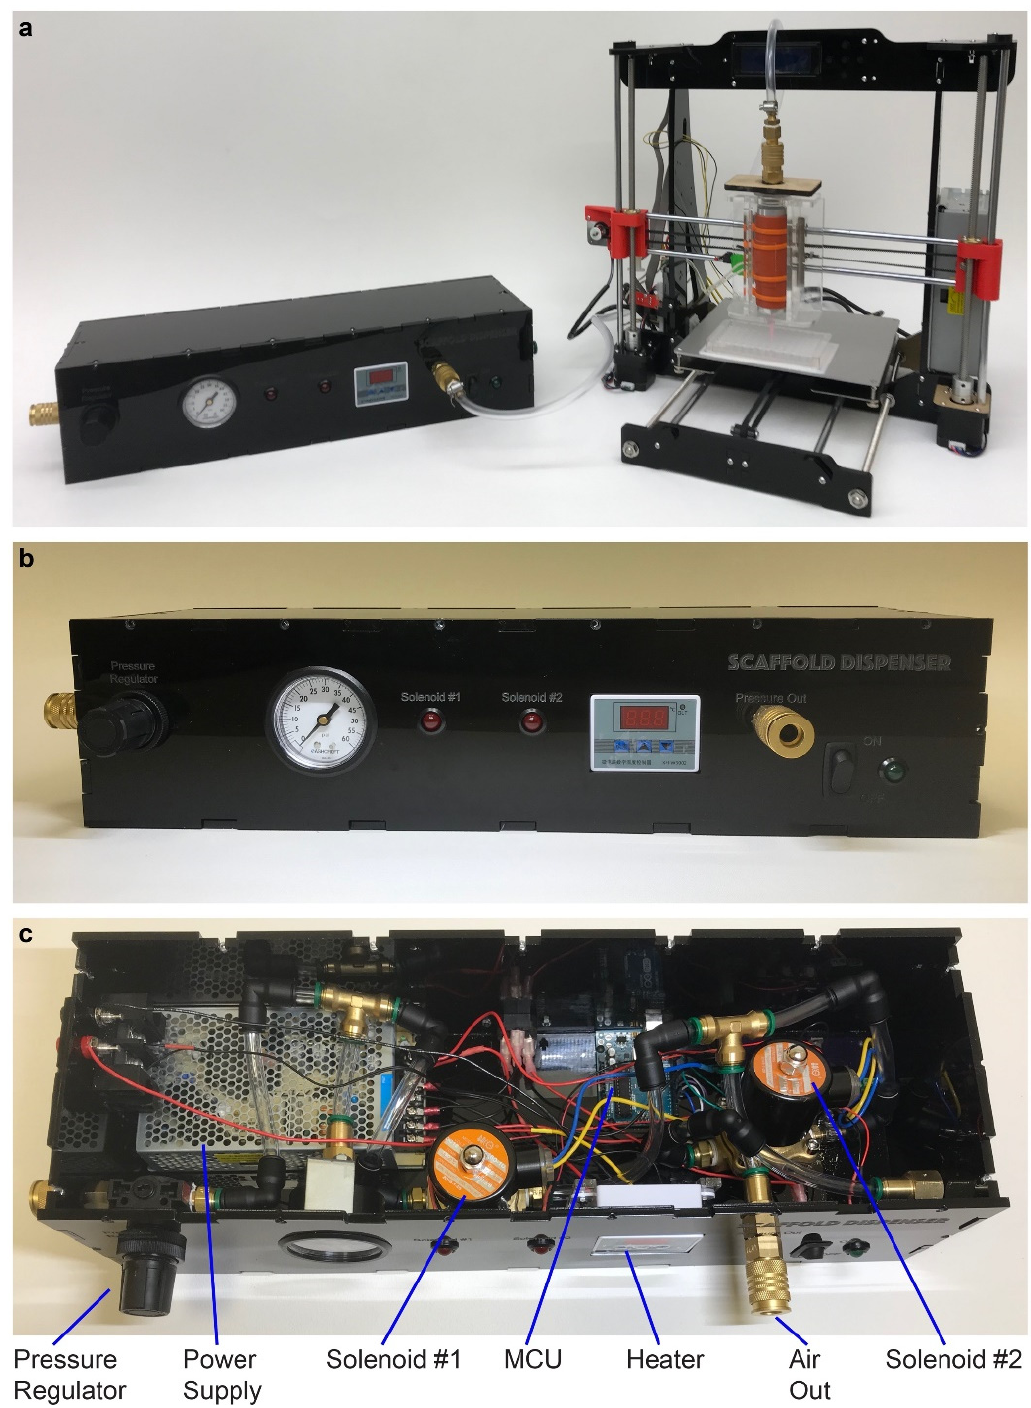
Figure 2. Realized scaffold dispenser. ( a ) Pneumatic housing (left) and modified 3D printer with syringe barrel (right). ( b ) Close-up of the pneumatic housing unit. ( c ) Inside the pneumatic housing unit with key components labelled. Pressurized gas is introduced to the pneumatic system through the quick connect fitting on the extreme left and is attached to the syringe barrel via the air out connection.